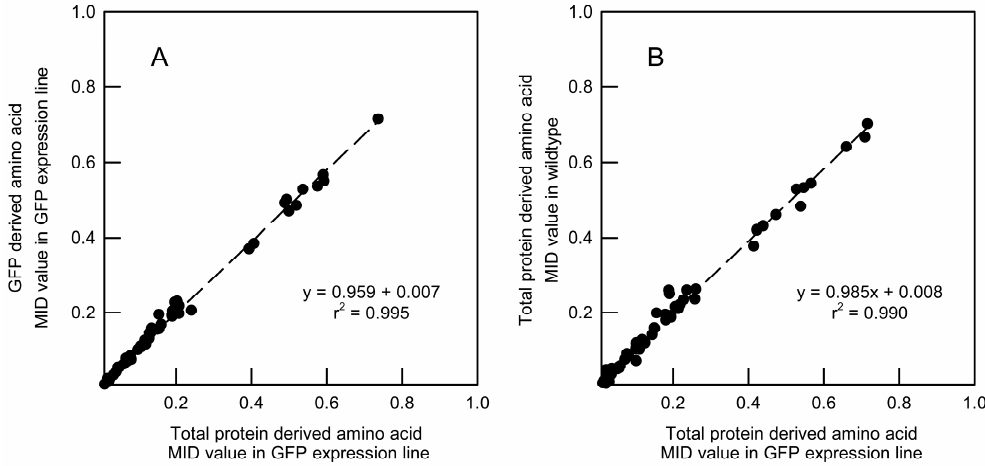
Figure 5. Validation of GFP as a reporter protein for csMFA. ( A ) Comparison of MIDs of amino acids derived from either GFP or total protein obtained from the roots of A. thaliana seedlings expressing GFP. The seedlings were grown in 20% [ 13 C 6 ]glucose and total ion counts measured for amino acid mass peaks were processed into MIDs to obtain average data on each mass peak for each fragment. The plot includes data from 12 amino acids, corresponding to the reliable detection of identical fragments in the two protein fractions. A paired t -test established that there was no significant difference between the abundances of individual amino acid isotopomers derived from total protein and GFP ( t -value = 0.063, d.f. = 68, p = 0.950). ( B ) Comparison of total protein MIDs from wild-type and GFP-expressing